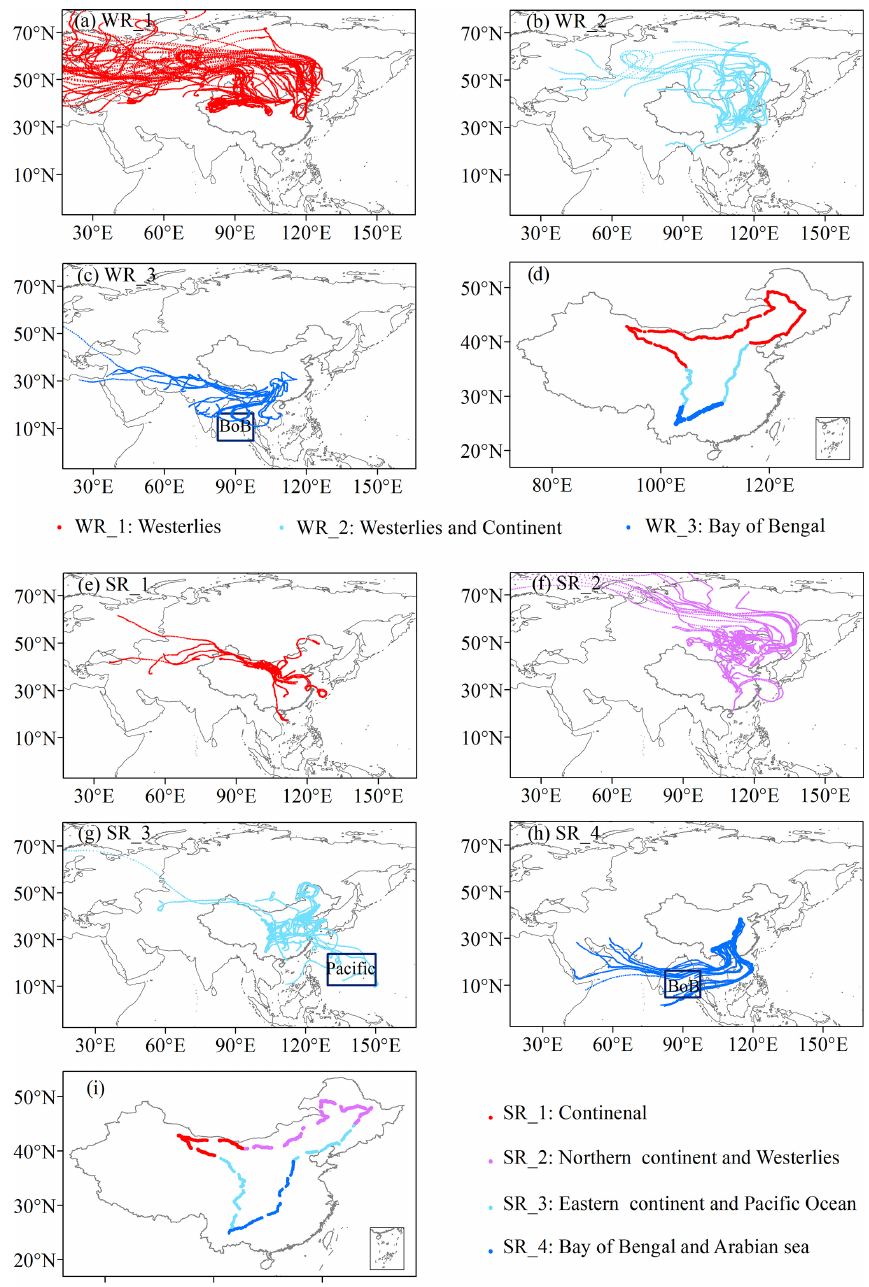
Figure 3. The backward trajectory results ( a , b , and c for the pre-monsoon period, and e , f , g , and h for the monsoon period) and the dividing of the study zones based on geographical origin of the air masses ( d for the pre-monsoon period and i for the monsoon period). Note: BoB is the abbreviation for the Bay of